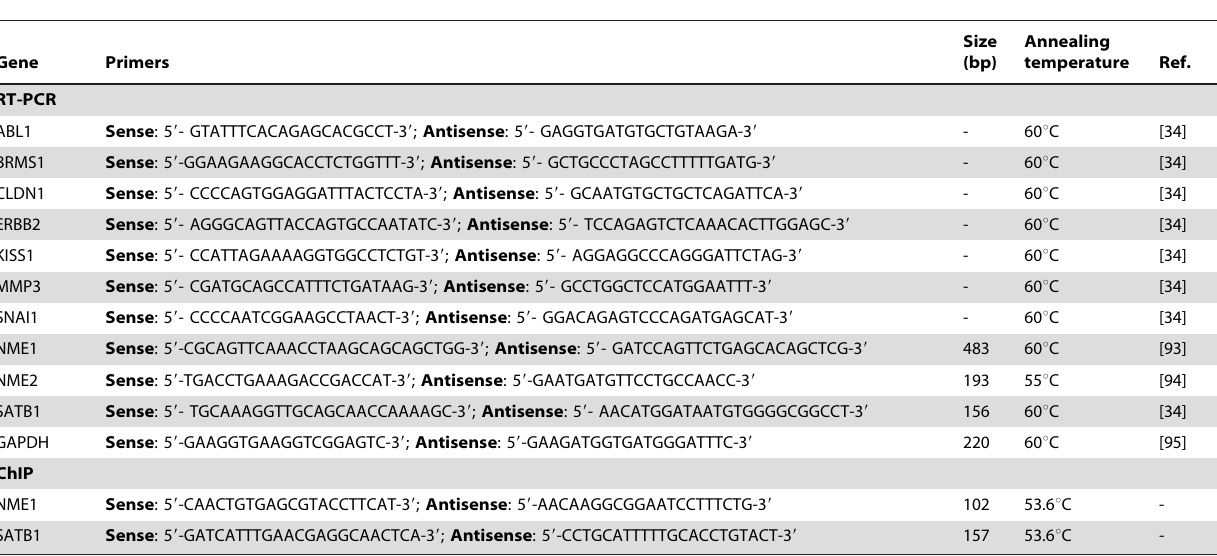
Table 1. Primer sequences and PCR conditions for reverse transcribed genes.